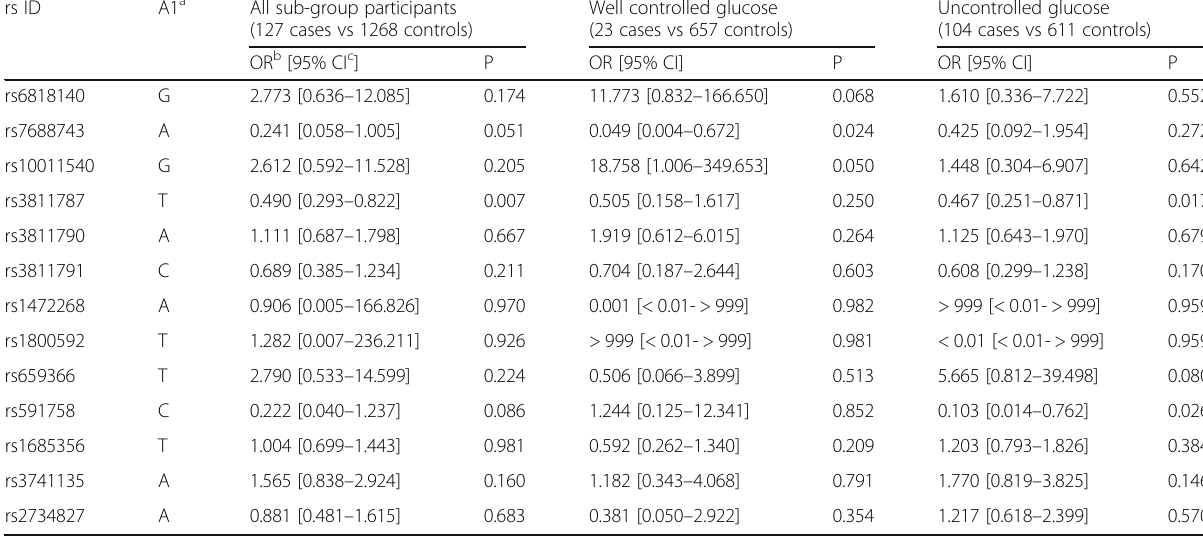
Table 6 The association between UCPs and sight threatening diabetic retinopathy in participants with and without controlled glucose rs ID A1 a All sub-group participants Well controlled glucose Uncontrolled glucose (127 cases vs 1268 controls) (23 cases vs 657 controls) (104 cases vs 611 controls) OR b [95% CI c ] P OR [95% CI]